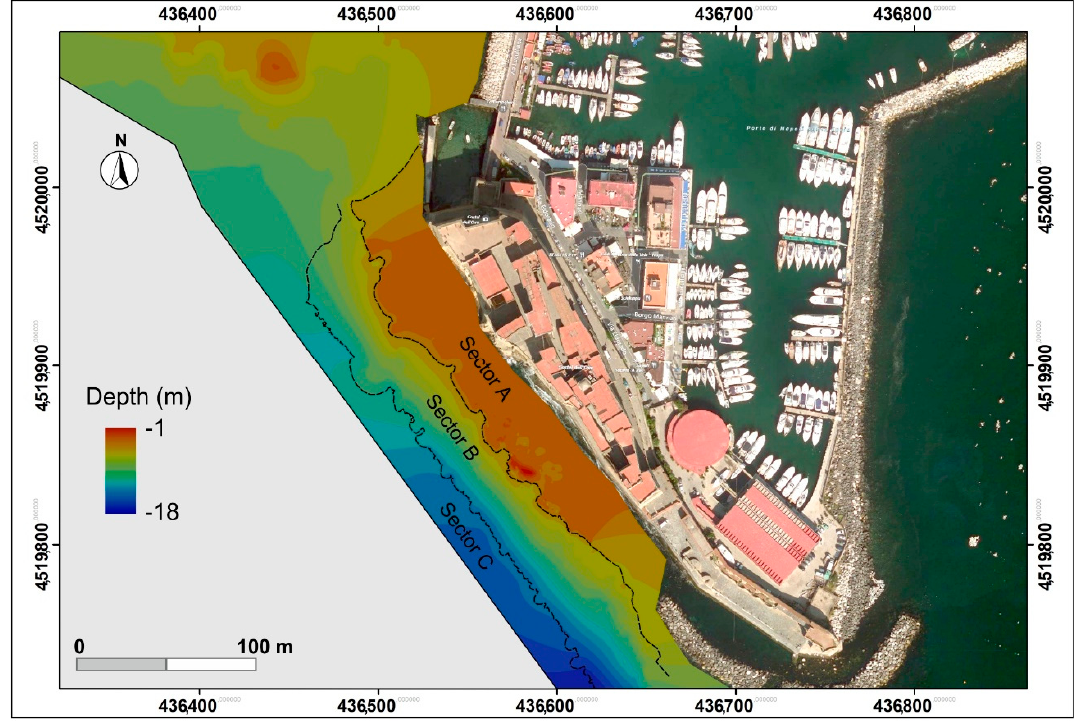
Figure 7. Bathymetric map of the study area.